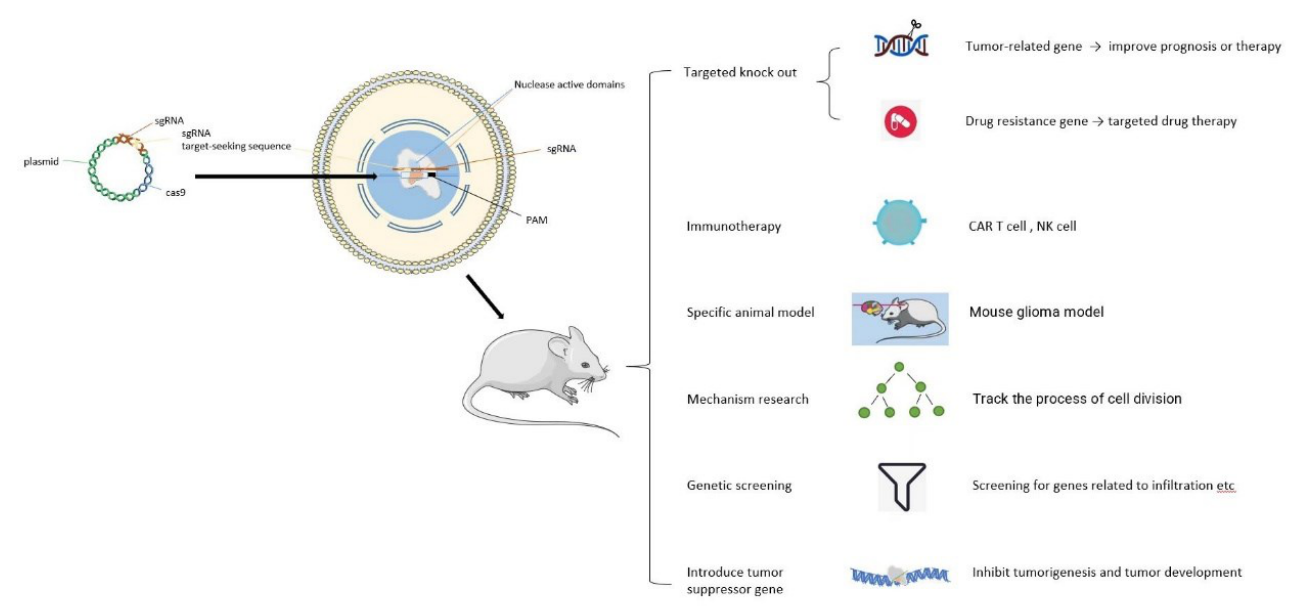
Figure 2. Advances in the research on and application of CRISPR/Cas9 in Glioma. CRISPR/CAS9 was introduced into a mouse model bearing glioma to impact the formation, progression, and treatment of glioma by different modes of action.